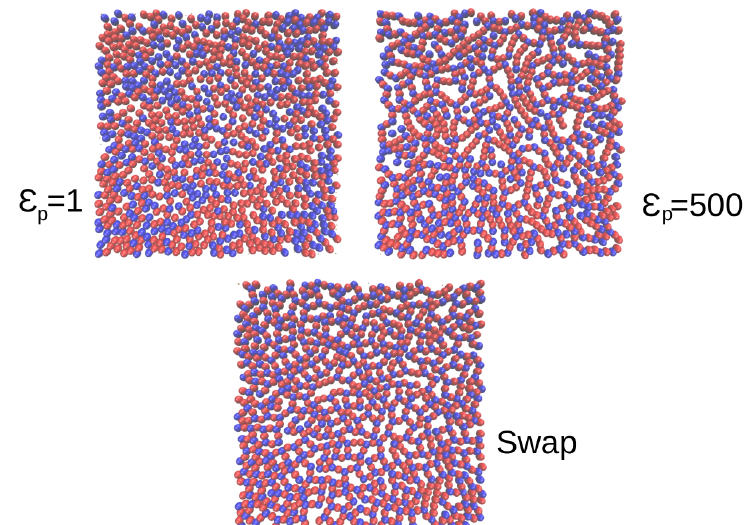
Figure 5: Self-assembly after 10 7 timesteps with different binding interactions. For = 1) the mixture of trifunctional (blue) and difunctional (red) beads weak bonds ( ε p hardly forms any persistent bond. When the bonds are strong ( ε also very long-lived and a network with long branches is assembled. There are in fact long sequences of bonded red beads that should not be present at